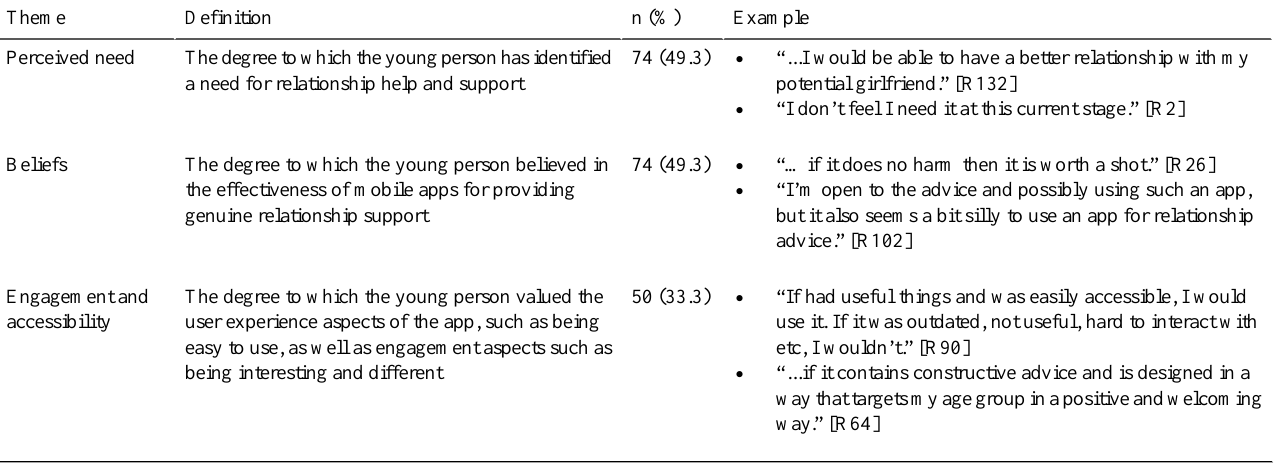
Table 4. Themes influencing the likelihood of app usage (N=150). R: respondent.